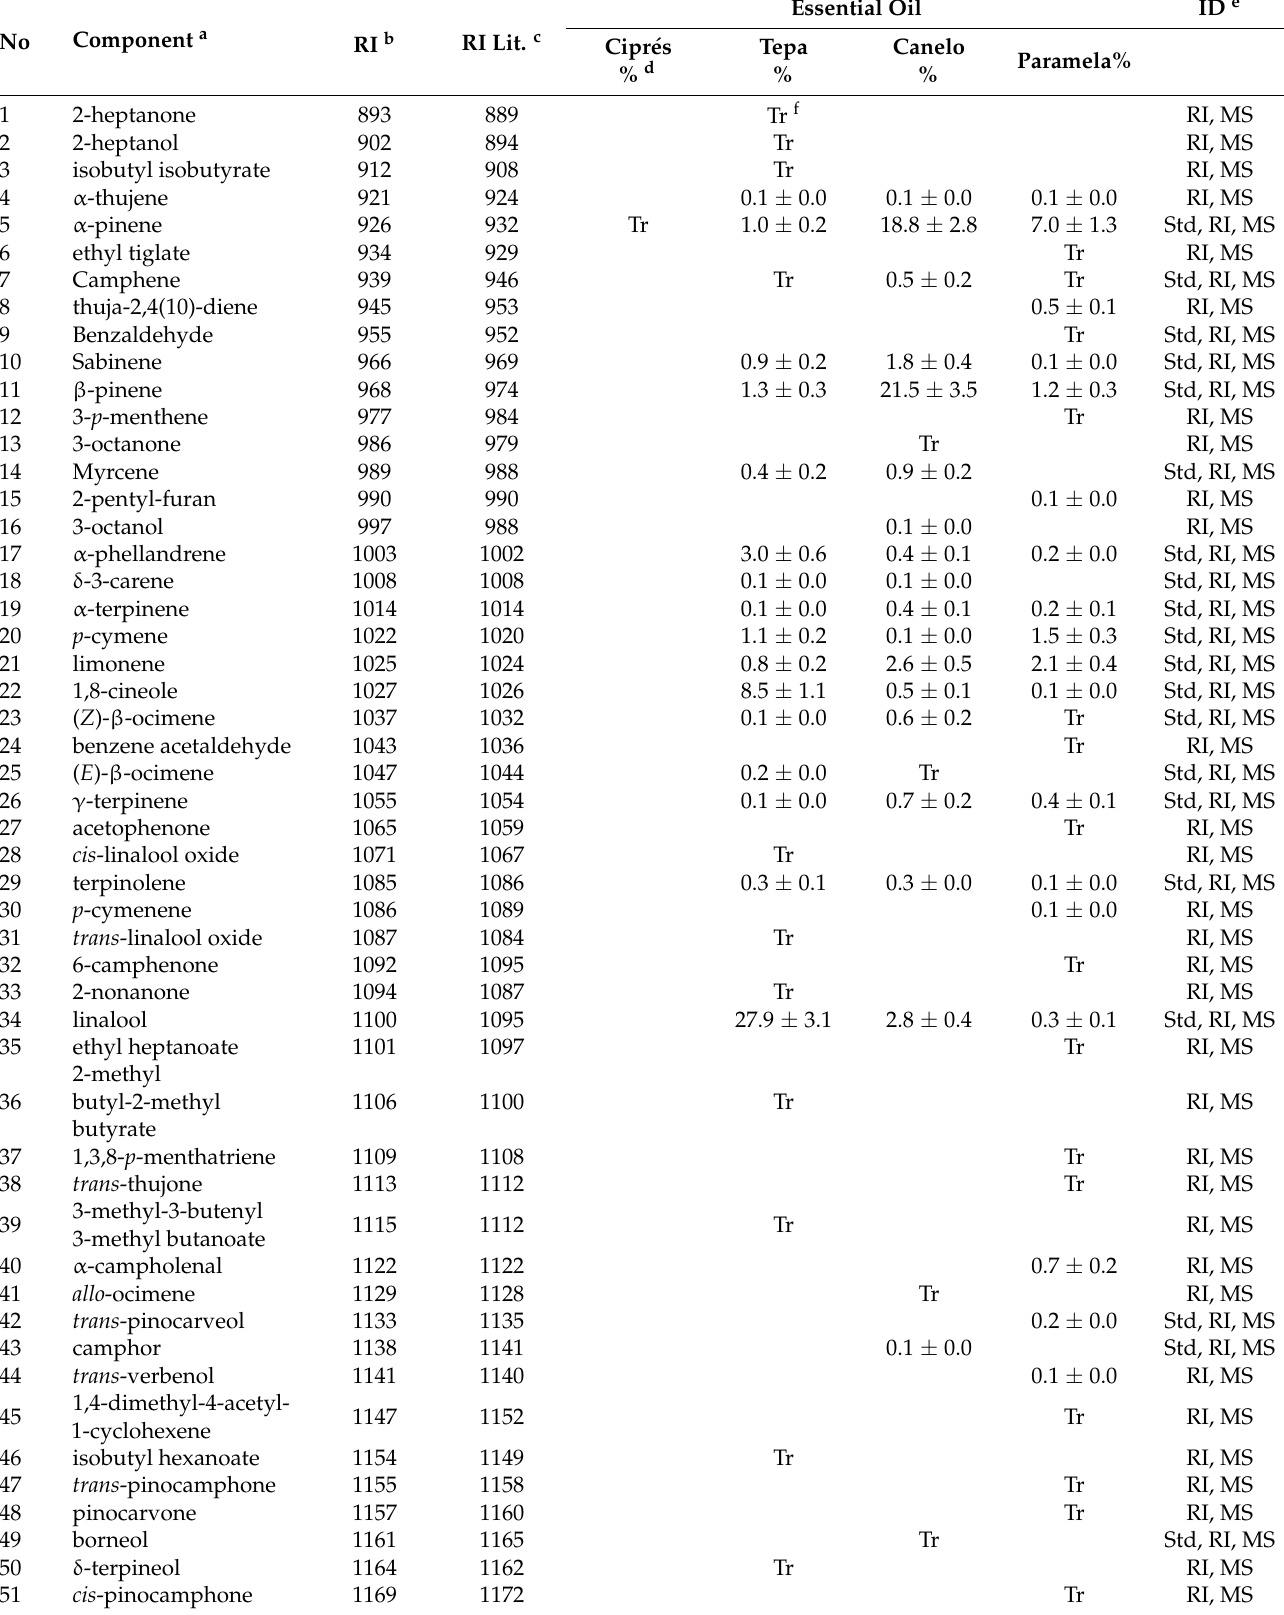
Table 1. Chemical composition of the essential oils from Pilgerodendron uviferum (cipr é s),